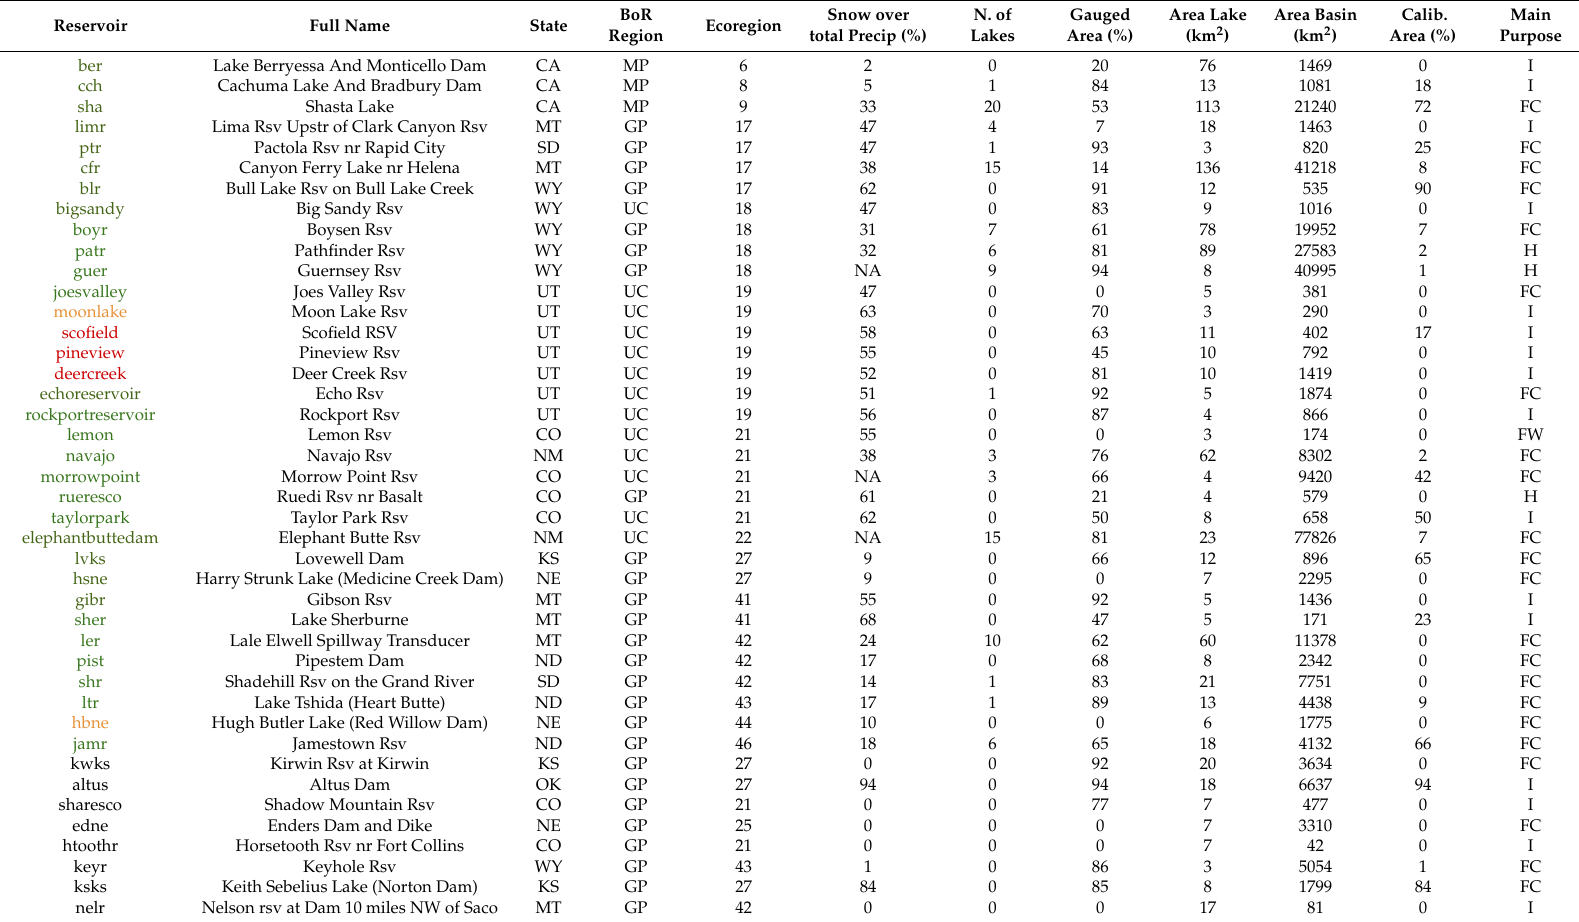
Table 1. Reservoir and drainage basin characteristics. The numbers in the Ecoregion column correspond with the legend of Figure 1. In the main purpose column abbreviations are used as following: I for Irrigation, FC for Flood Control, H for Hydroelectric, FW for Fish and Wildlife pond. BoR regions are abbreviated as MP for Mid Pacific, GP for Great Plains, UC for Upper Colorado. Colors in column one indicates quality from reconstructed total inflows, from red (noted data defects) to green (high fidelity), where orange is moderate